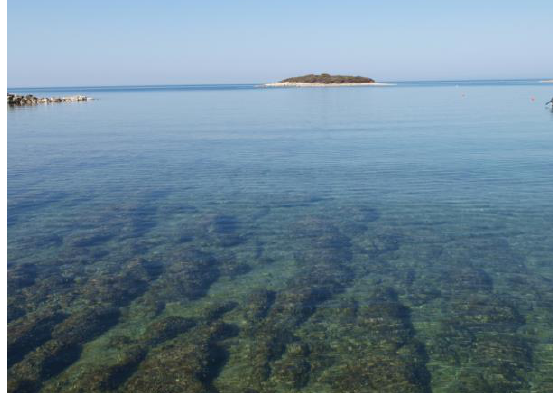
Figure 9. Kolone, Croatia. The photograph was taken on March 29 around 12.30 during the ALB data acquisition and documents the smooth water surface and this calm and almost windless day (Photo: Davor